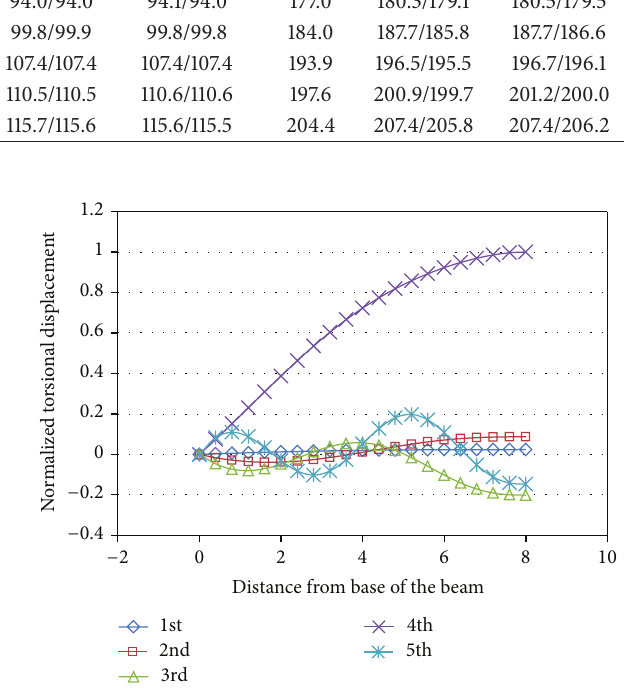
Figure 9: Bending component of the first five natural modes; preloaded cantilevered beam.